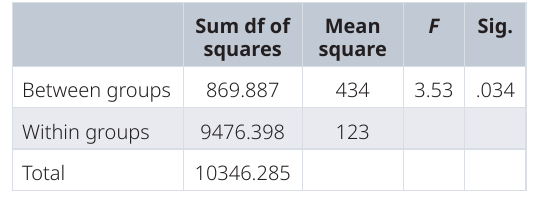
Table 5. one way ANOVA for relaxation between fictional narrative consumption of 3 groups.